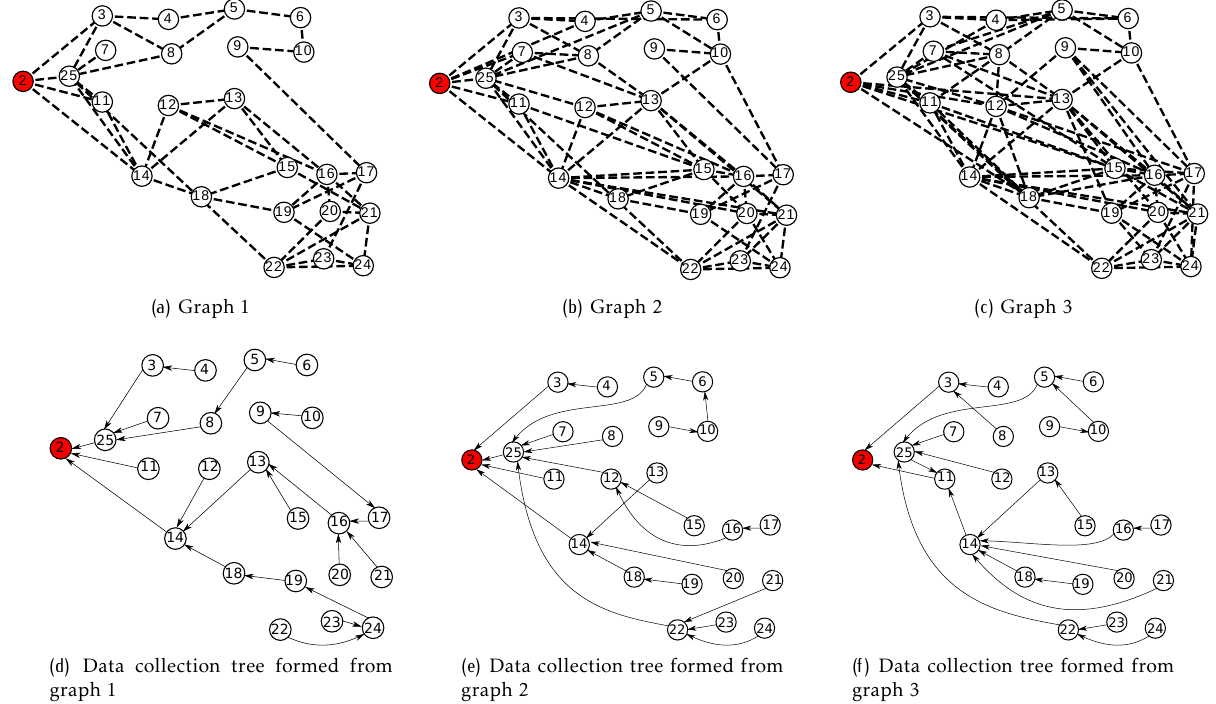
2. Reduction in remaining capacity for various nodes varies from 135.7 mAh (NodeID 6) to 764.26 mAh (NodeID 24). 3. If we look at the tree used for the data collection (tree 1), the nodes which spent most of the energy are leaf nodes. This might be because of the fact that they are the ones which went into sleep stage exceptions also. For example Node ID6, finds its position somewhere towards the bottom of the energy expenditure table.